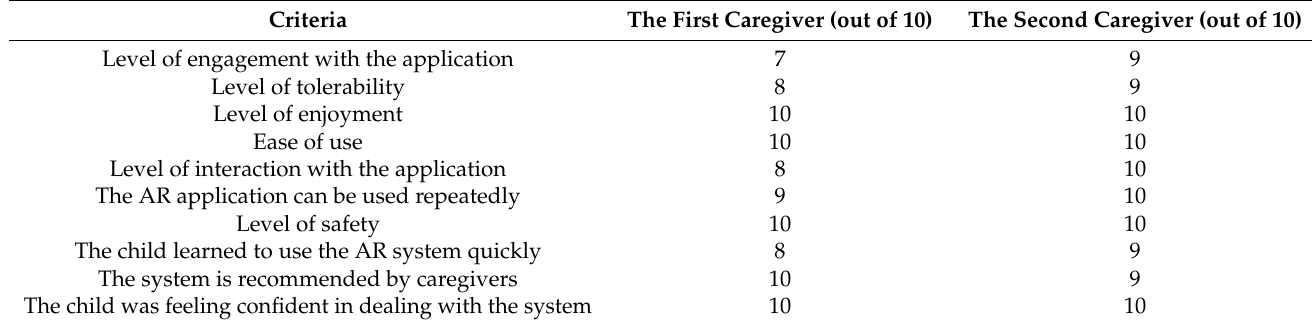
Table 5. The assessment of the application by caregivers for TD children.